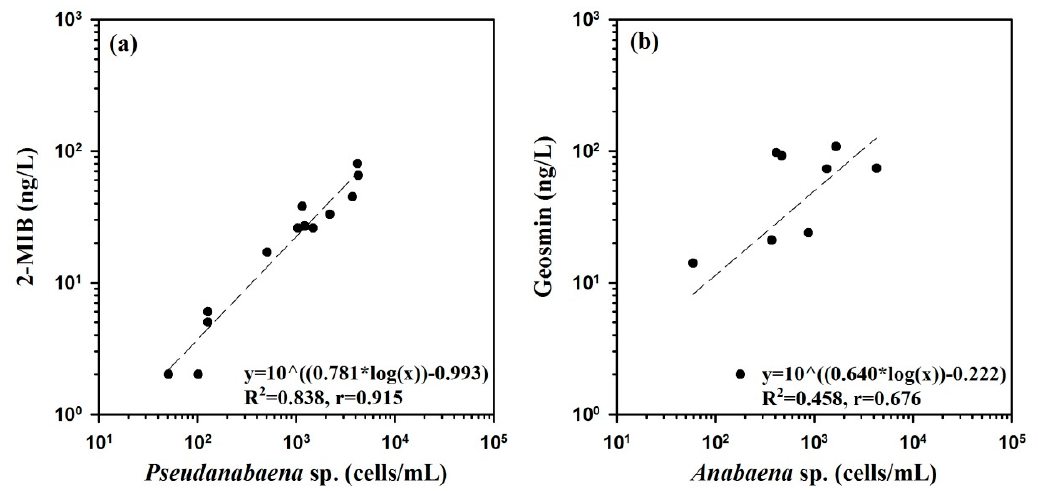
Figure 4. Relationship between ( a ) 2-MIB concentration and Pseudanabaena sp. abundance and ( b ) geosmin concentration and Anabaena sp. abundance in the Jinyang Reservoir.